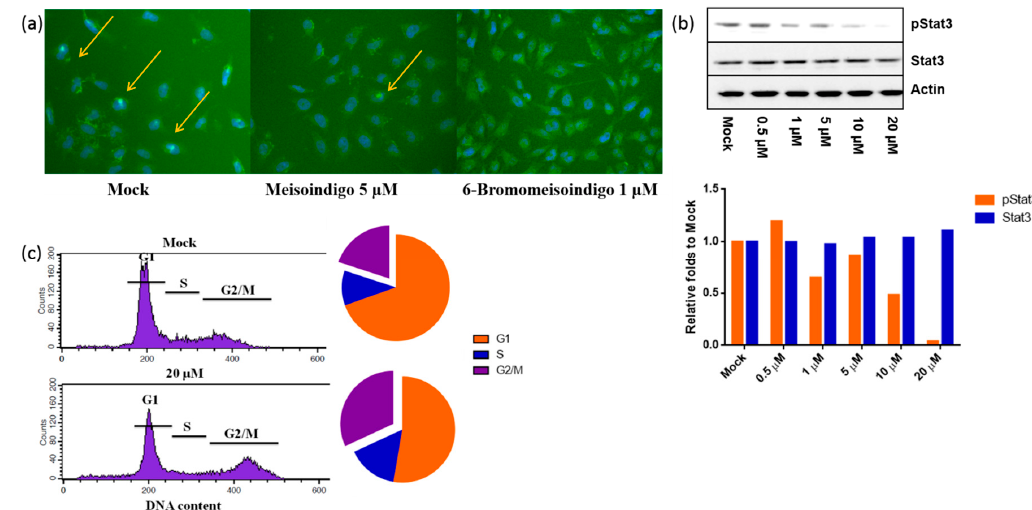
Figure 4 Figure 4. ( a ) Meisoindigo and 6-bromo-meisoindigo reduced Stat3 activity in HeLa cells. Cells were treated as indicated and fixed in formaldehyde. Specific antibodies against phospho-Stat3 (Y705) and Hoechst stain were used for immunocytochemistry assay; ( b ) 6-bromo-meisoindigo reduced Stat3 activity in HeLa cells in a dose-dependent manner. HeLa cells were incubated with compound for 30 min. The whole cell lysate was used for immunoblot. Specific antibodies against Stat3 and phospho-Stat3 (Y705) were applied. β -actin served as loading control and 0.1% DMSO as mock; ( c ) 6-bromo-meisoindigo induced a G2/M cell cycle arrest in HeLa cells, determined by FACS